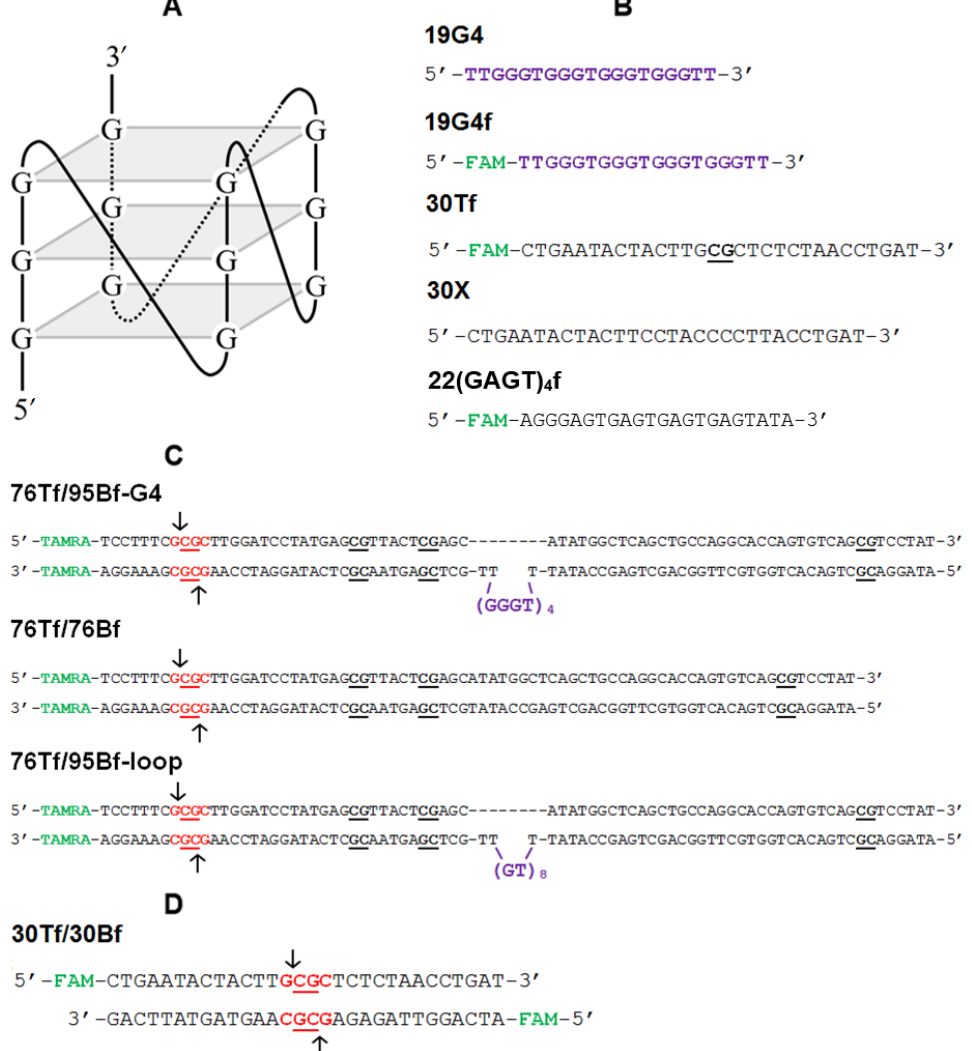
Figure 2. Abbreviation and sequence of oligonucleotides and DNA duplexes tested in this work. ( A ) Schematic representation of the parallel G4 structure formed by the d(GGGT) 4 sequence. ( B ) 19-nt oligonucleotides capable of forming the G4 structure as well as single-stranded DNA controls. ( C ) The DNA duplex in which the G4 structure was stabilized in a double-stranded context; 76 bp perfect DNA duplex and DNA duplex with looped out d(GT) 8 moiety used as double-stranded controls. ( D ) The 30 bp DNA duplex used as a known MTase substrate. CpG sites are highlighted in bold and are underlined; arrows indicate the sites of cleavage by restriction endonuclease Hin6I (R.Hin6I) (its recognition site is highlighted in red: 5 ′ -G ↓ CG C-3 ′ ); TAMRA and FAM fluorophores are indicated in green.